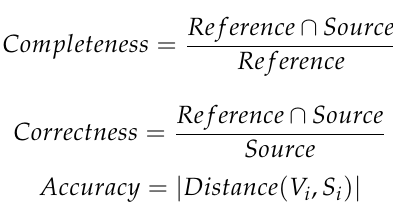
Figure 11. Local navigation network generation and adjustment. The yellow areas indicate the connecting transition space. The burgundy dots are the convex points. The pink dots are the concave points. The red dots and green dots are abstract nodes. The thick blue lines indicate the connection relationship between nodes. The pink lines are the wall segments intersecting with the navigation network.